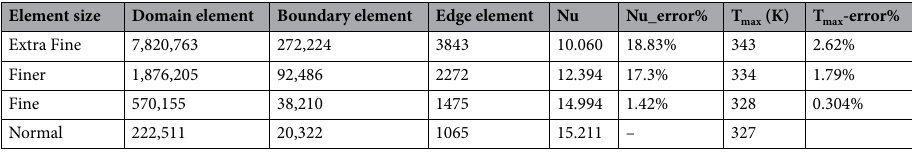
Table 2. Mesh sensitivity test for rectangular mini channel heat sink at Re = 400, q = 180 kW/m 2 .